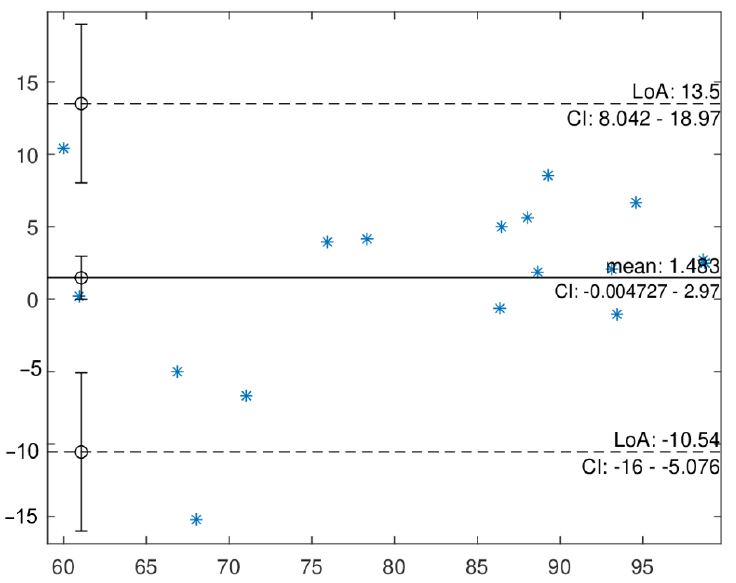
Figure 6. The Bland–Altman plot for α + β + γ , 4 Hz case. The LOA means limits of agreement and CI is the confidence